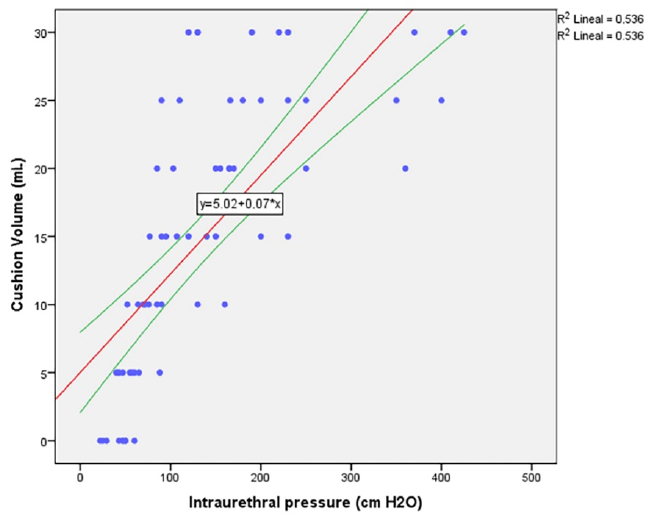
Figure 3. Correlation between urethral pressure and ATOMS cushion volume. There is a correlation between intraurethral pressure baseline with ATOMS placed unfilled and filled at atmospheric pressure ( p = 0.038), and also between intraurethral pres- sure before ATOMS placement and with ATOMS placed and filled at atmospheric pres- sure plus 4 mL ( p = 0.047). Additionally, a correlation was found between ATOMS filling to a medium-range volume (10 mL and 15 mL, p = 0.000; 15 mL and 20 mL, p = 0.004; 10 mL and 20 mL, p = 0.019) and also to a high-range volume (20 mL and 25 mL, p = 0.007; 25 mL and 30 mL, p = 0.003). These figures evidence that, although the pressure variation